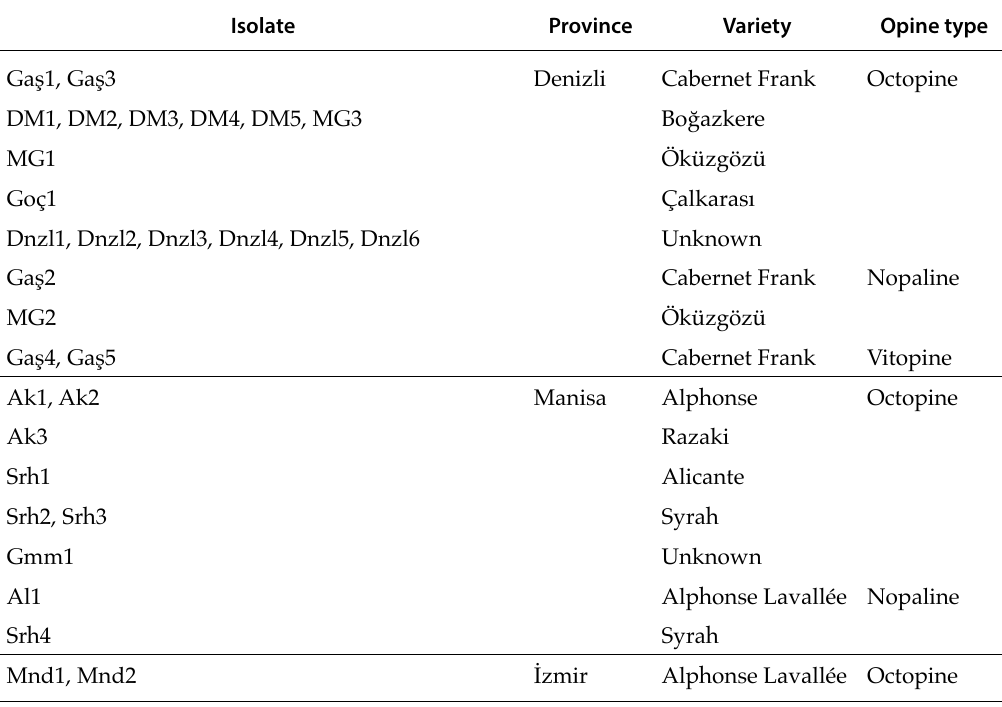
Table 1 . Strain information and opine types of Rhizobium vitis used in this